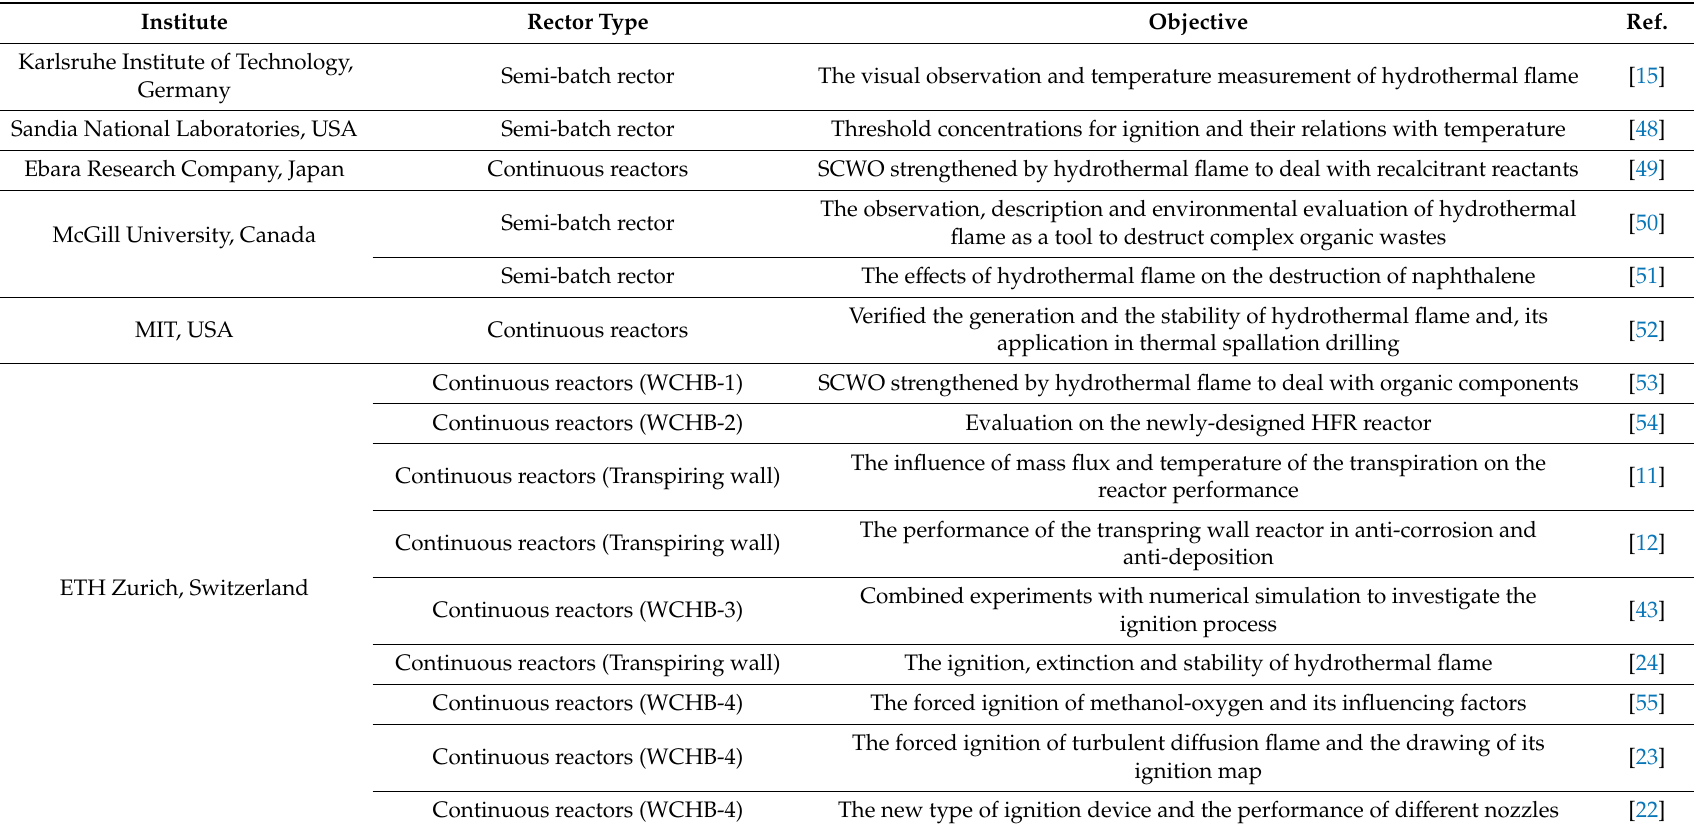
Table 1. Reactors and main objectives of worldwide research